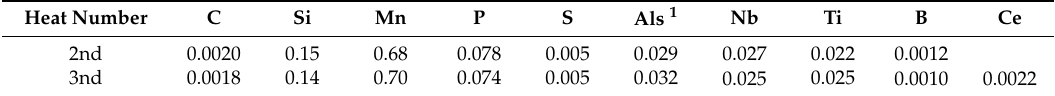
Table 1. Chemical composition of the samples (wt.%).